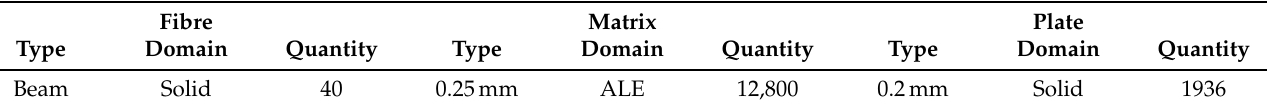
Table 7. Numerical parameters for the shear flow model.